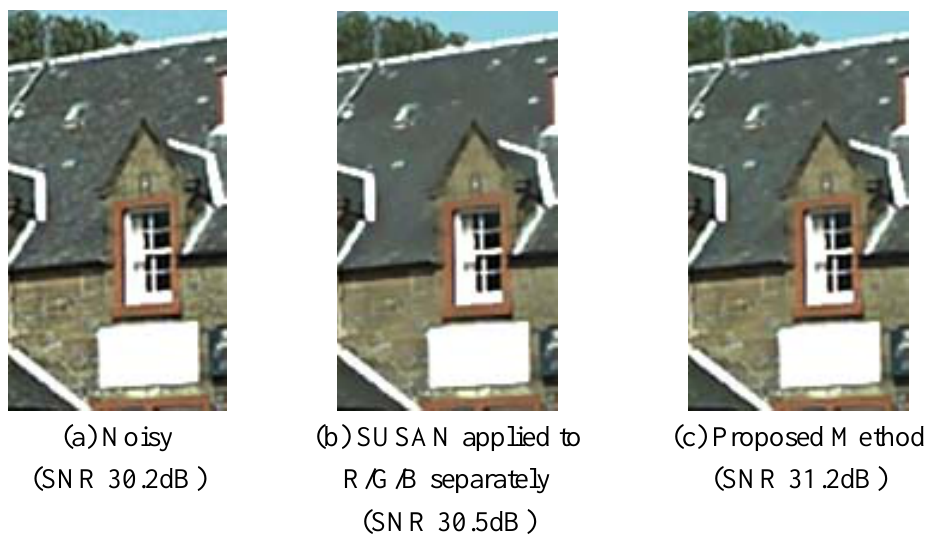
Figure 15. A magnified detail of Figure 14(a), to better evaluate the comparison between the proposed filter and the SUSAN algorithm applied on R/G/B channels separately. Both methods preserve details very well, although the proposed technique is capable to better preserve texture sharpness; the enhancement is visible by looking at the wall and the roof texture. The proposed method uses fewer resources as the whole filtering action takes place on one plane of CFA data.